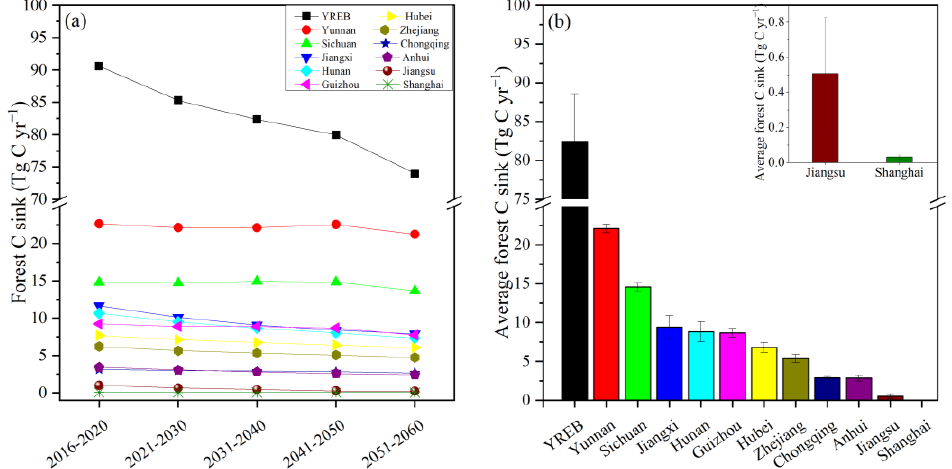
Figure 6. Predicted variations in forest biomass C sink from 2016 to 2060 in the YREB. ( a ) shows the forest biomass C sink of the YREB and various provinces and municipalities from 2015 to 2060; ( b ) represents the average forest C sinks in the YREB and various provinces and municipalities from 2015 to 2060.